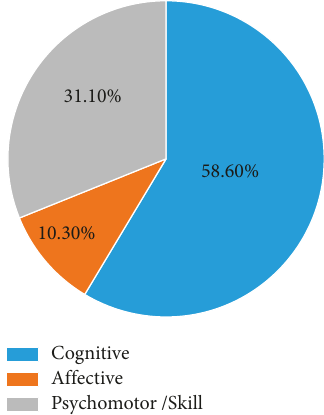
Figure 2: The most frequently used research elements in IBL studies in Ethiopia (2010 to Table 6: Frequently used research design/methods in IBL studies in Ethiopia (2010 to 2021). Research Design